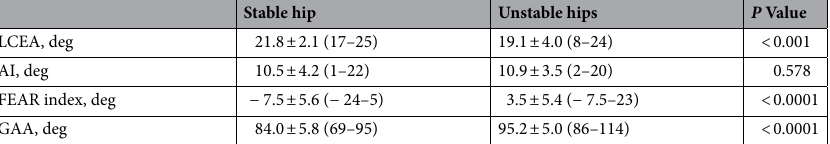
Table 4. Radiographic measurements by stability diagnosis a . a Data are shown as mean ± SD (range). AI